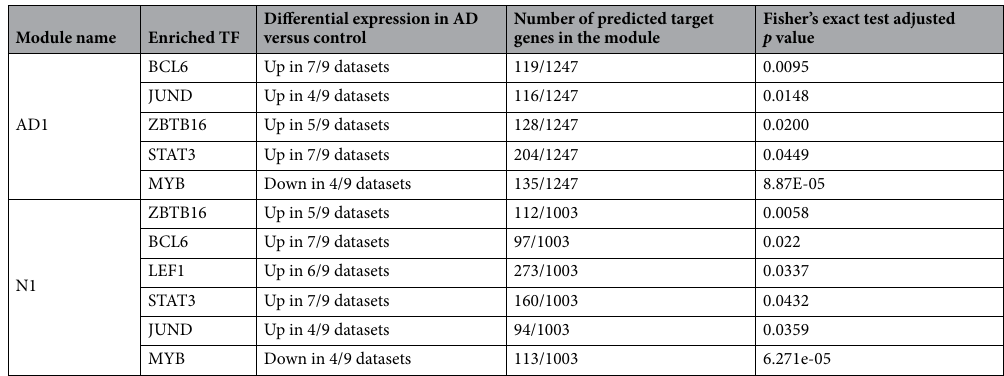
Table 2. Neuron modules AD1/N1 are predicted to be targeted by differentially expressed